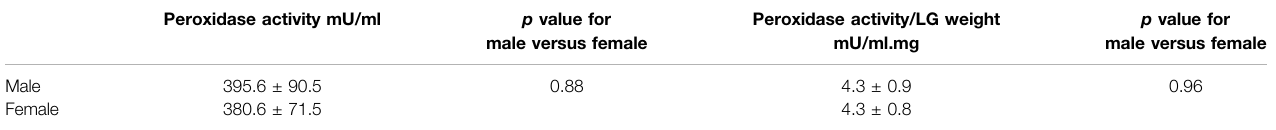
TABLE 3 | Peroxidase activity in Wistar rats LG. The comparison included eight-week-old males and females ( n = 7/group). The assay was conducted with a colorimetric assay ( Amplex Red ; Molecular Probes, Eugene, OR, United States) and read at a spectrophotometer (SpectroMax M2, Molecular Devices, Sunnyvale, CA, United States) after 30 min. Comparisons were performed by Student ’ s t test for the two groups and ANOVA for the three groups. The p value was signi fi cant when < 0.05. Peroxidase activity mU/ml p value for Peroxidase activity/LG weight male versus female